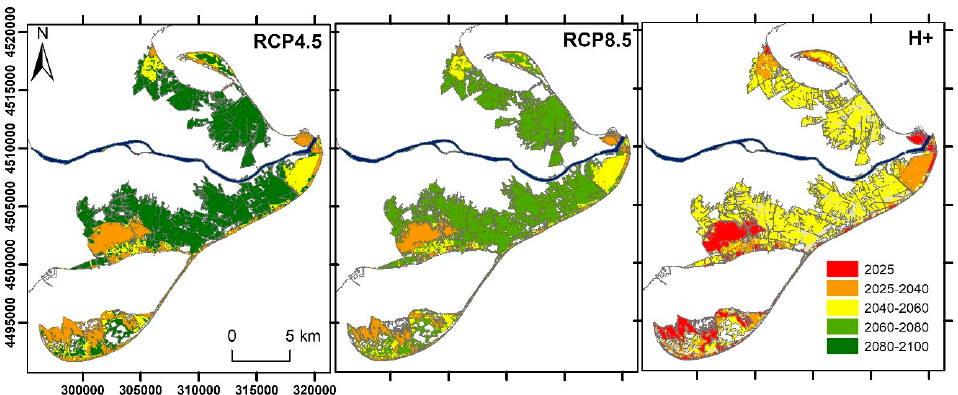
Figure 10. Timeframes of inundation from 2025 to 2100 in the ED at different elevation ranges (0–0.1 m, 0.1–0.2 m, and 0.2–0.5 m) under RCP4.5, RCP8.5, and H+ scenarios. (The geographic coordinate system is ETRS89/UTM zone 31N.)